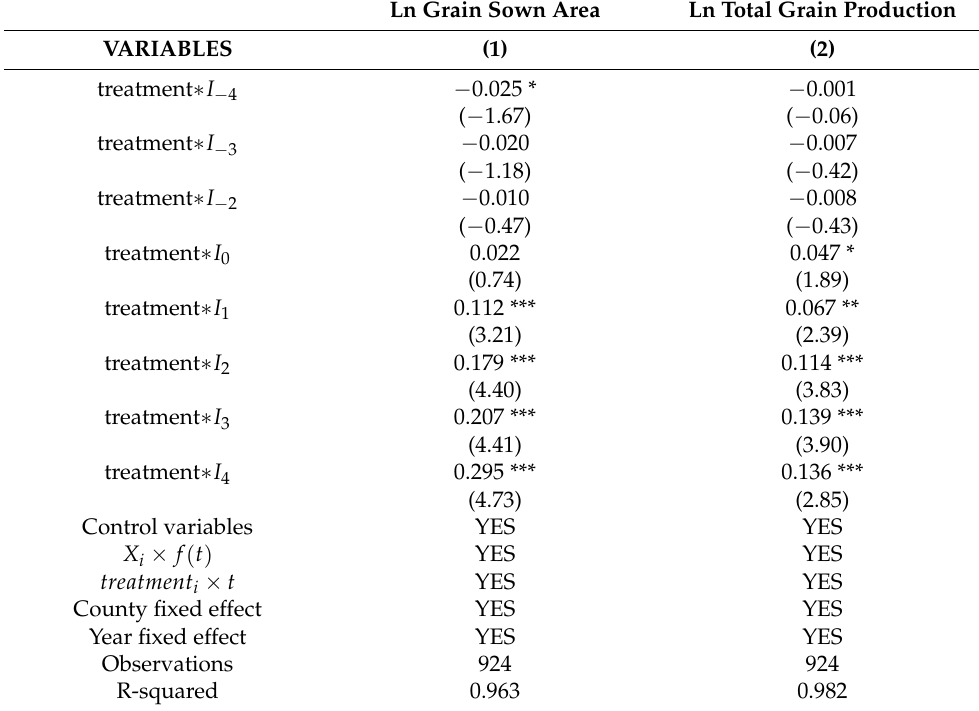
Table 4. Policy dynamic